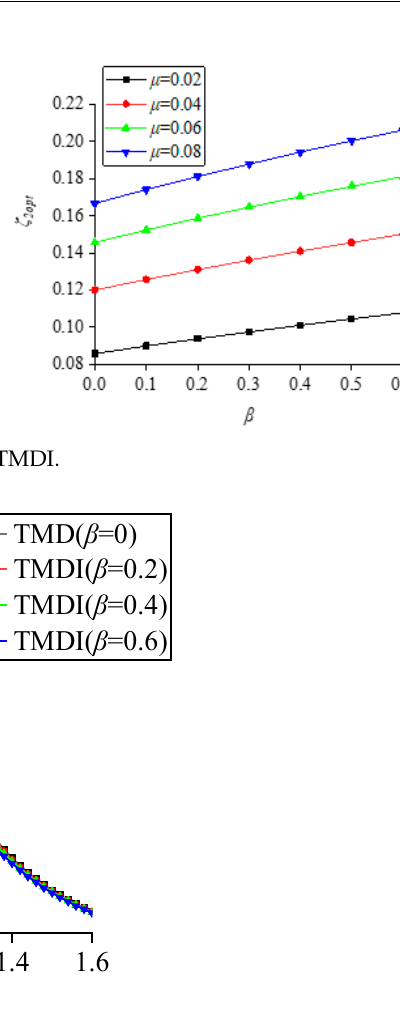
Figure 8. Frequency response curve comparison.